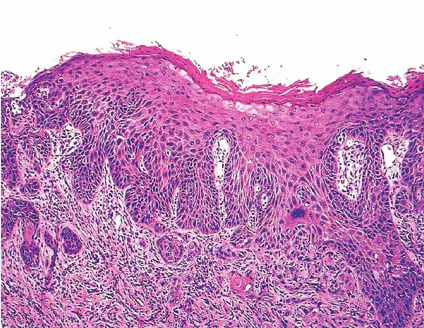
Figure 3: Hematoxylin-eosin-stained section from the proliferative lesion in the left mandibular area, showing invasive squamous cell carcinoma (original magnification